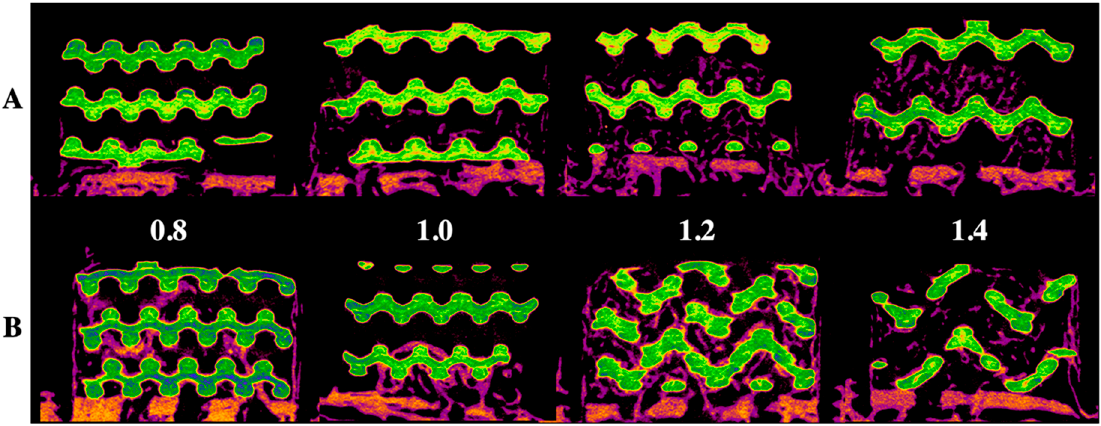
Figure 1. Radiological evaluation of the 3D-printed HA/TCP scaffold with pore sizes of 0.8, 1.0, 1.2, and 1.4 mm: ( A ) after four weeks, ( B ) after eight weeks; green color: HA/TCP scaffold and purple color: newly generated bone.